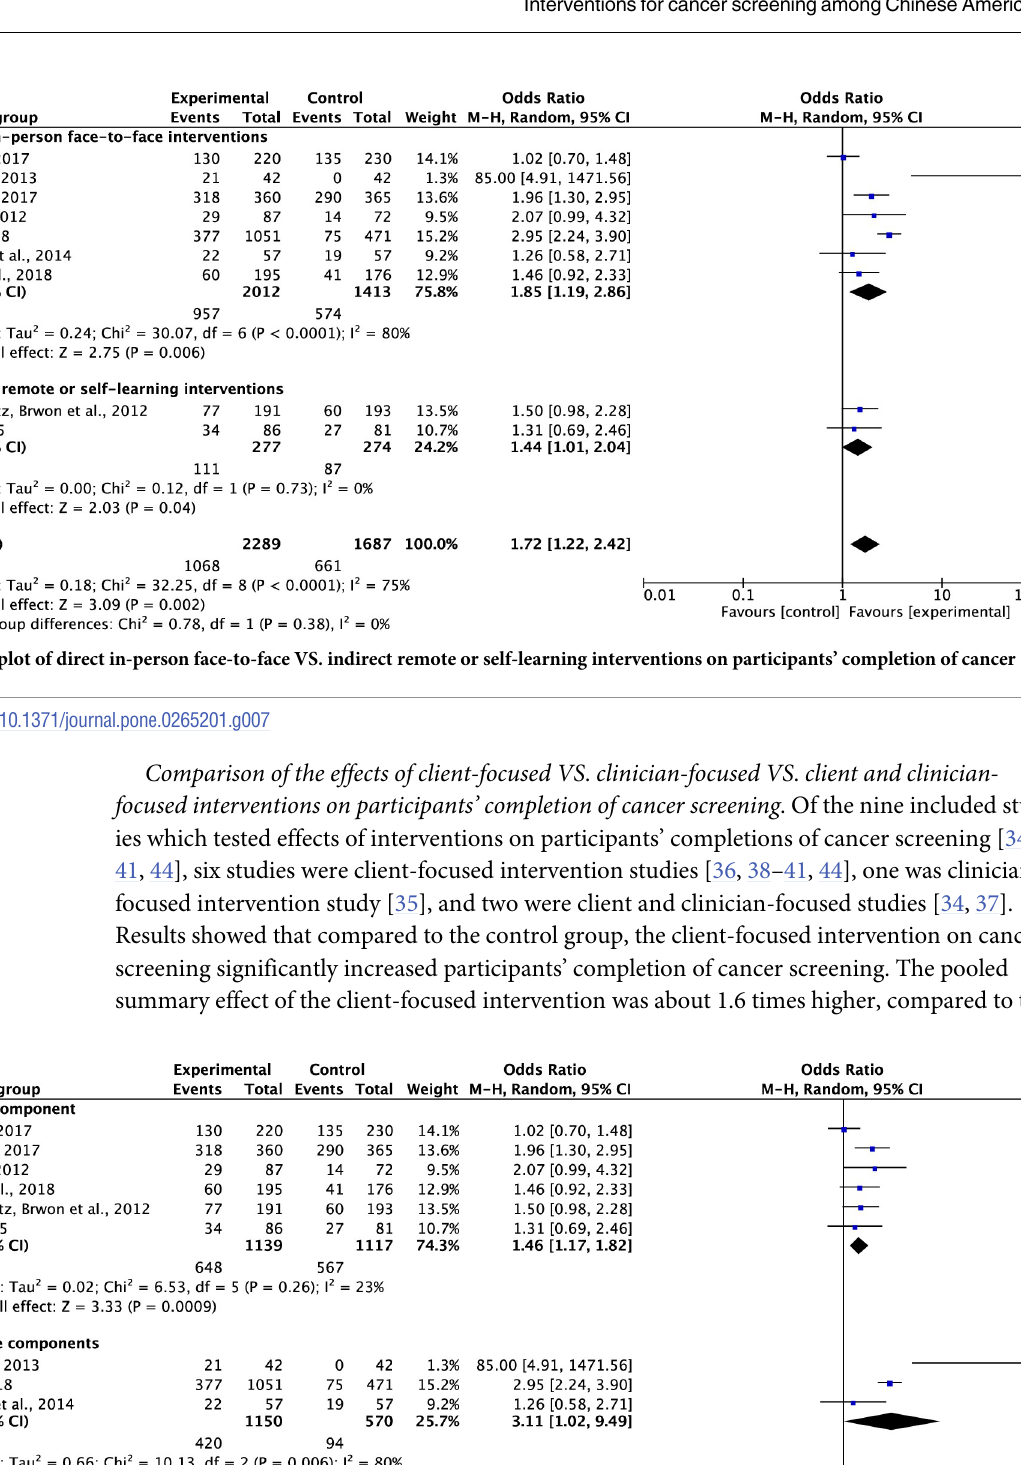
PLOS ONE | https://doi.org/10.1371/journal.pone.0265201 March 16,